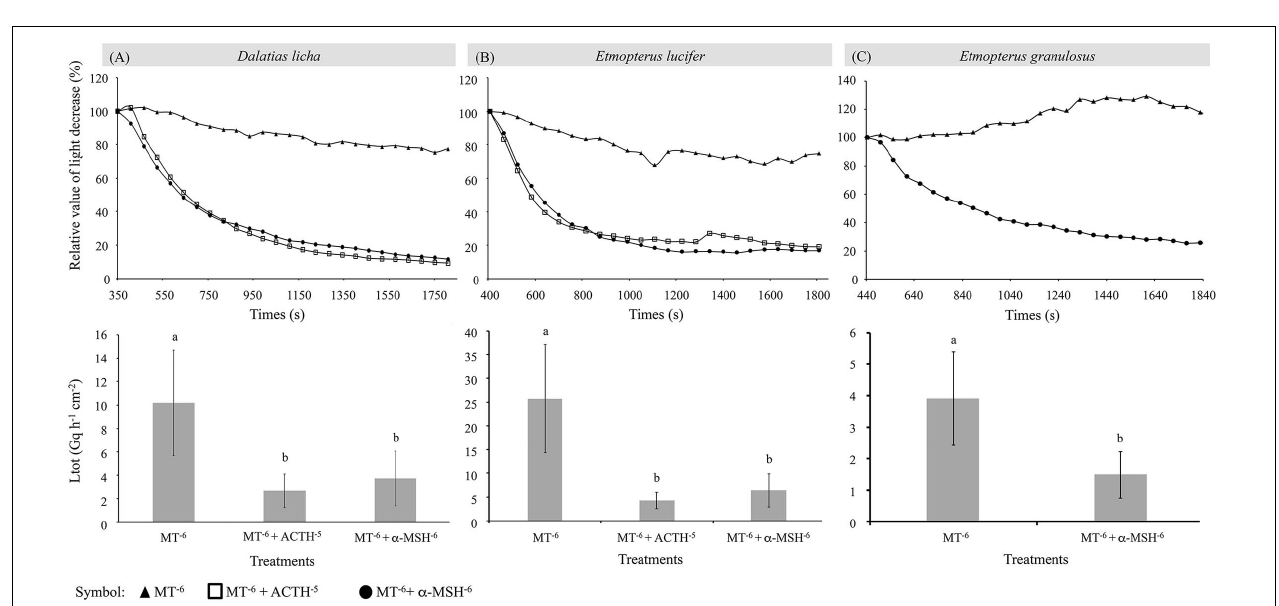
FIGURE 6 | Effect of ACTH and α -MSH on luminescence induced by MT in the studied species. Time course of the light produced (expressed as percentage of maximal melatonin control value), and total amount of light produced (Gq h − 1 cm − 2 ) after melatonin pretreatment from ventral skin patches under melanocortin treatments (ACTH 10 − 5 mol L − 1 / α -MSH 10 − 6 mol L − 1 ) for (A) Dalatias licha ( n = 10), (B) Etmopterus lucifer ( n = 7), and (C) Etmopterus granulosus ( n = 4 – no ACTH treatment). Hormonal treatments are expressed in mol L − 1 . Different lettering indicates statistical differences [ANOVA: D. licha F (2,33) = 2.585, P -value = 0.0437; E. lucifer F (2,18) = 14.482, P -value = 0.0002; Kruskal-Wallis ANOVA: E. granulosus χ 2 (1) = 3.857, P -value = 0.0495]. Error bars correspond to SEM.